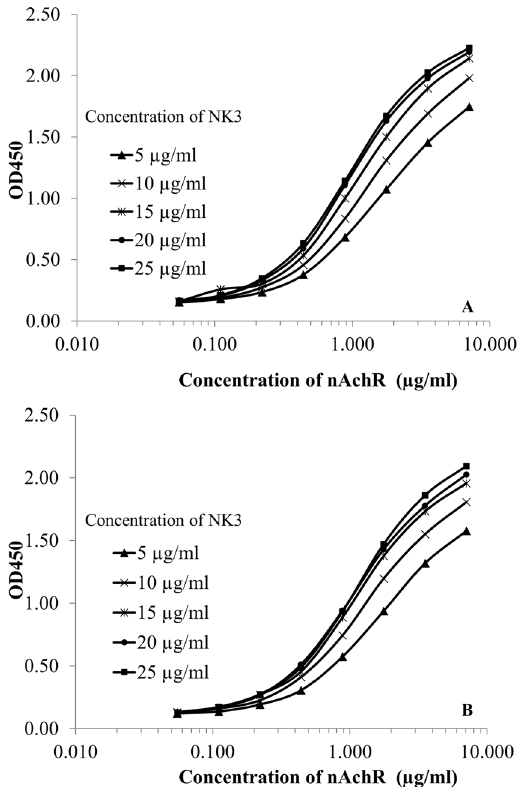
Figure 1. Determinations of optimal concentrations of NK3, purified nAChR, rat anti-nAChR serum and goat anti-rat IgG conjugated HRP. A: goat anti-rat IgG-HRP conjugate at 1:4500, B: goat anti-rat IgG-HRP conjugate at 1:6000.